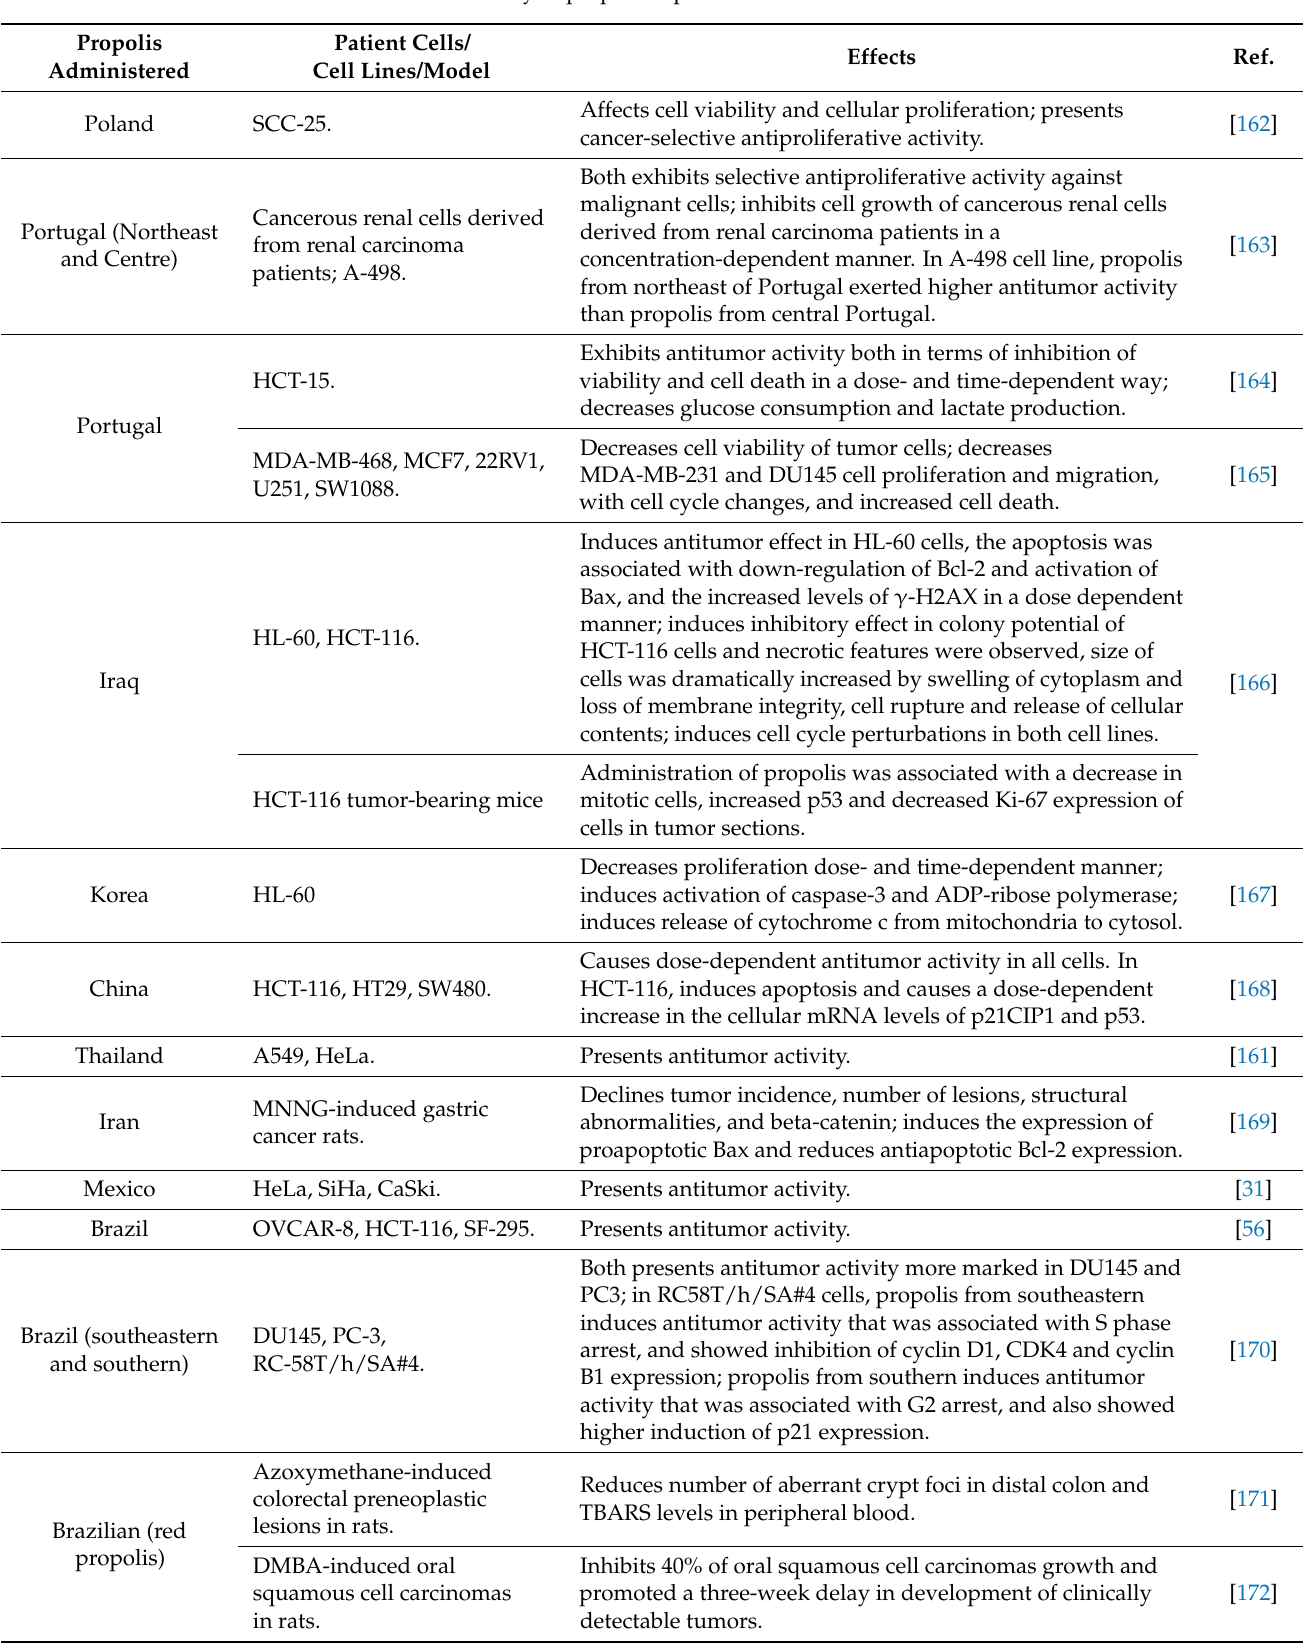
Table 6. Antitumor activity of propolis reported in in vitro and in vivo